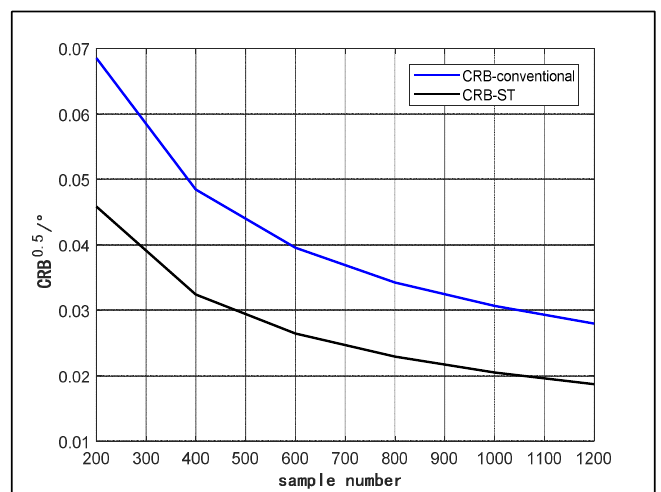
Figure 5. CRB of signal direction estimation versus sample number. Figure 4. CRB of signal direction estimation versus sample number. Figure 4. CRB of signal direction estimation versus sample number.